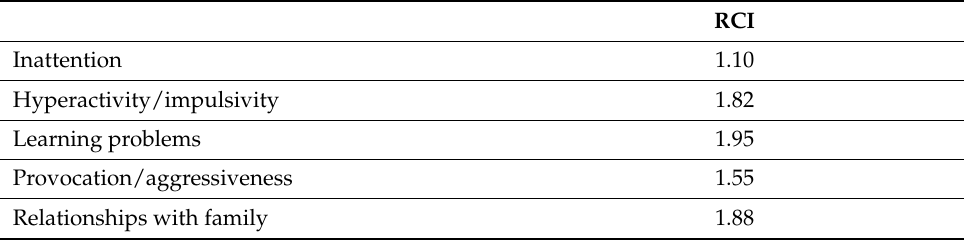
Table 5. Summary table of the RCI values of the scores at Conners-3 scale